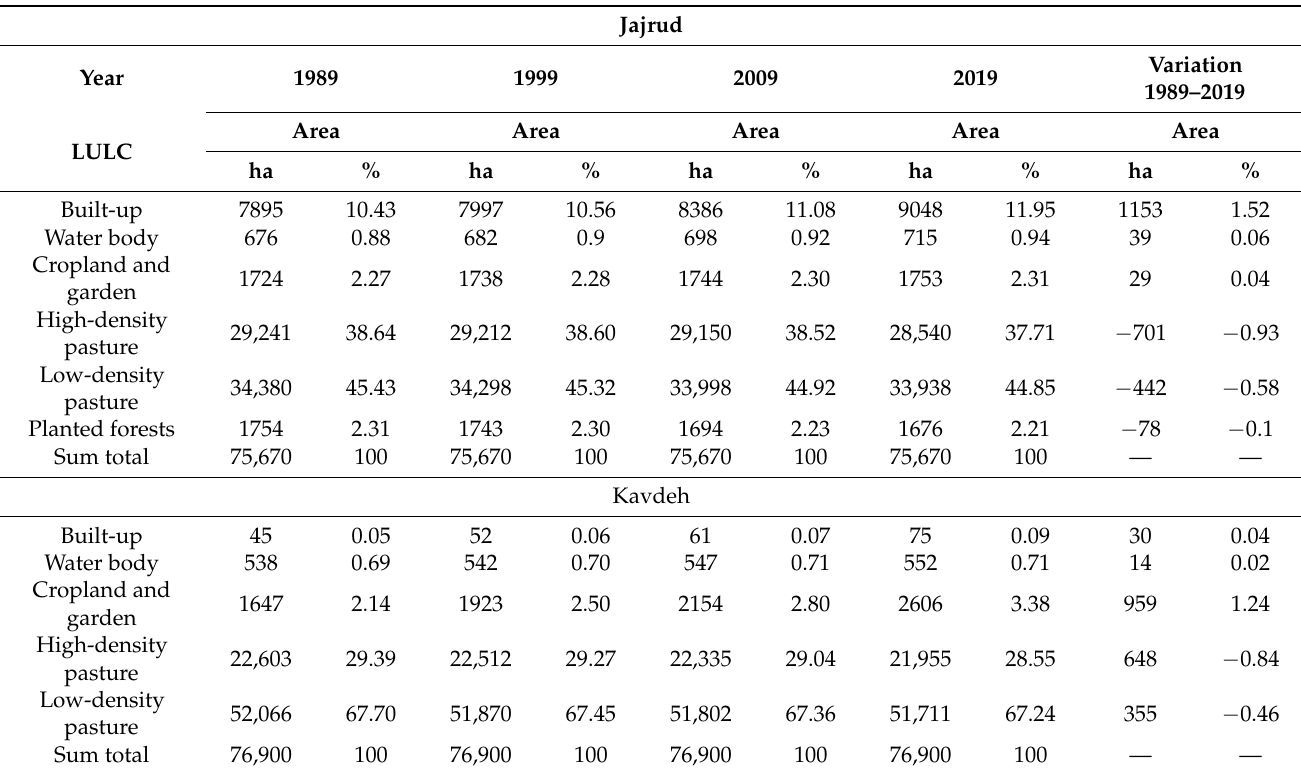
Table 5. Changes of LULC classes in two Protected Areas in the Tehran province, Iran, over 1989–2019.